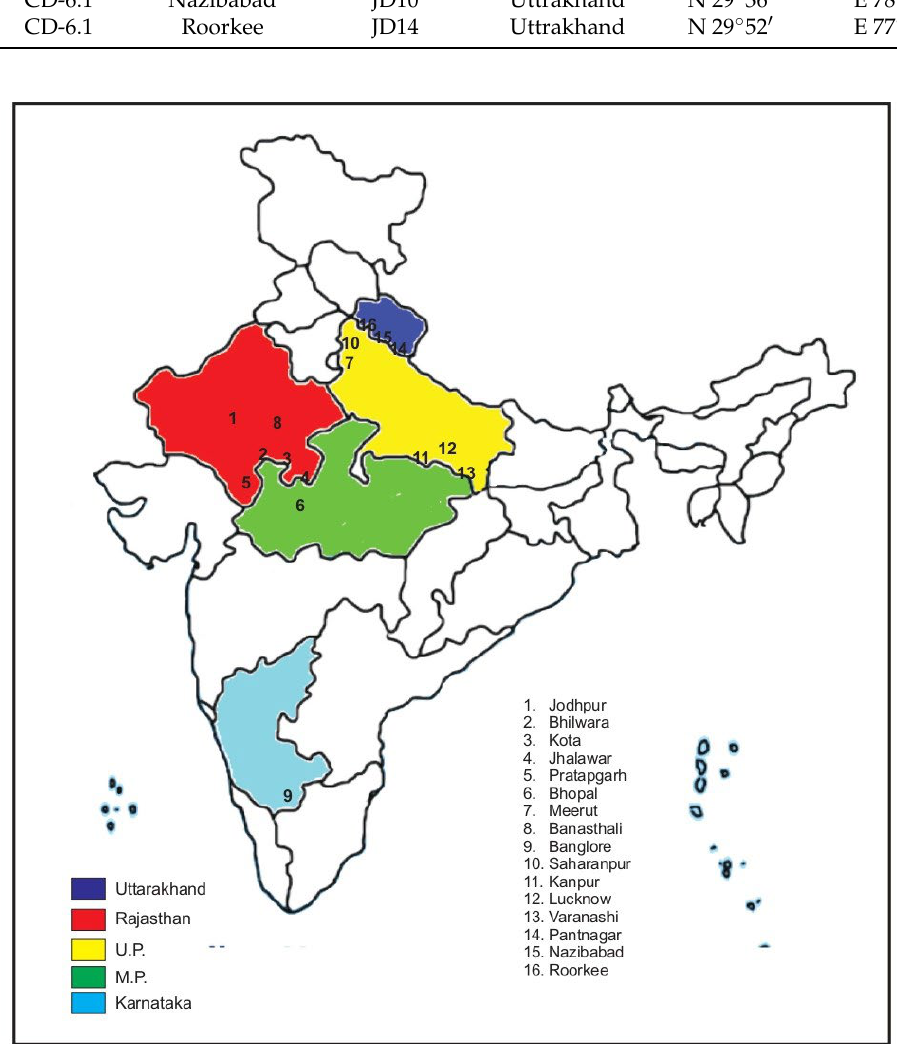
Figure 1. India map showing S. cumini accessions gathered from agro-ecological zones.